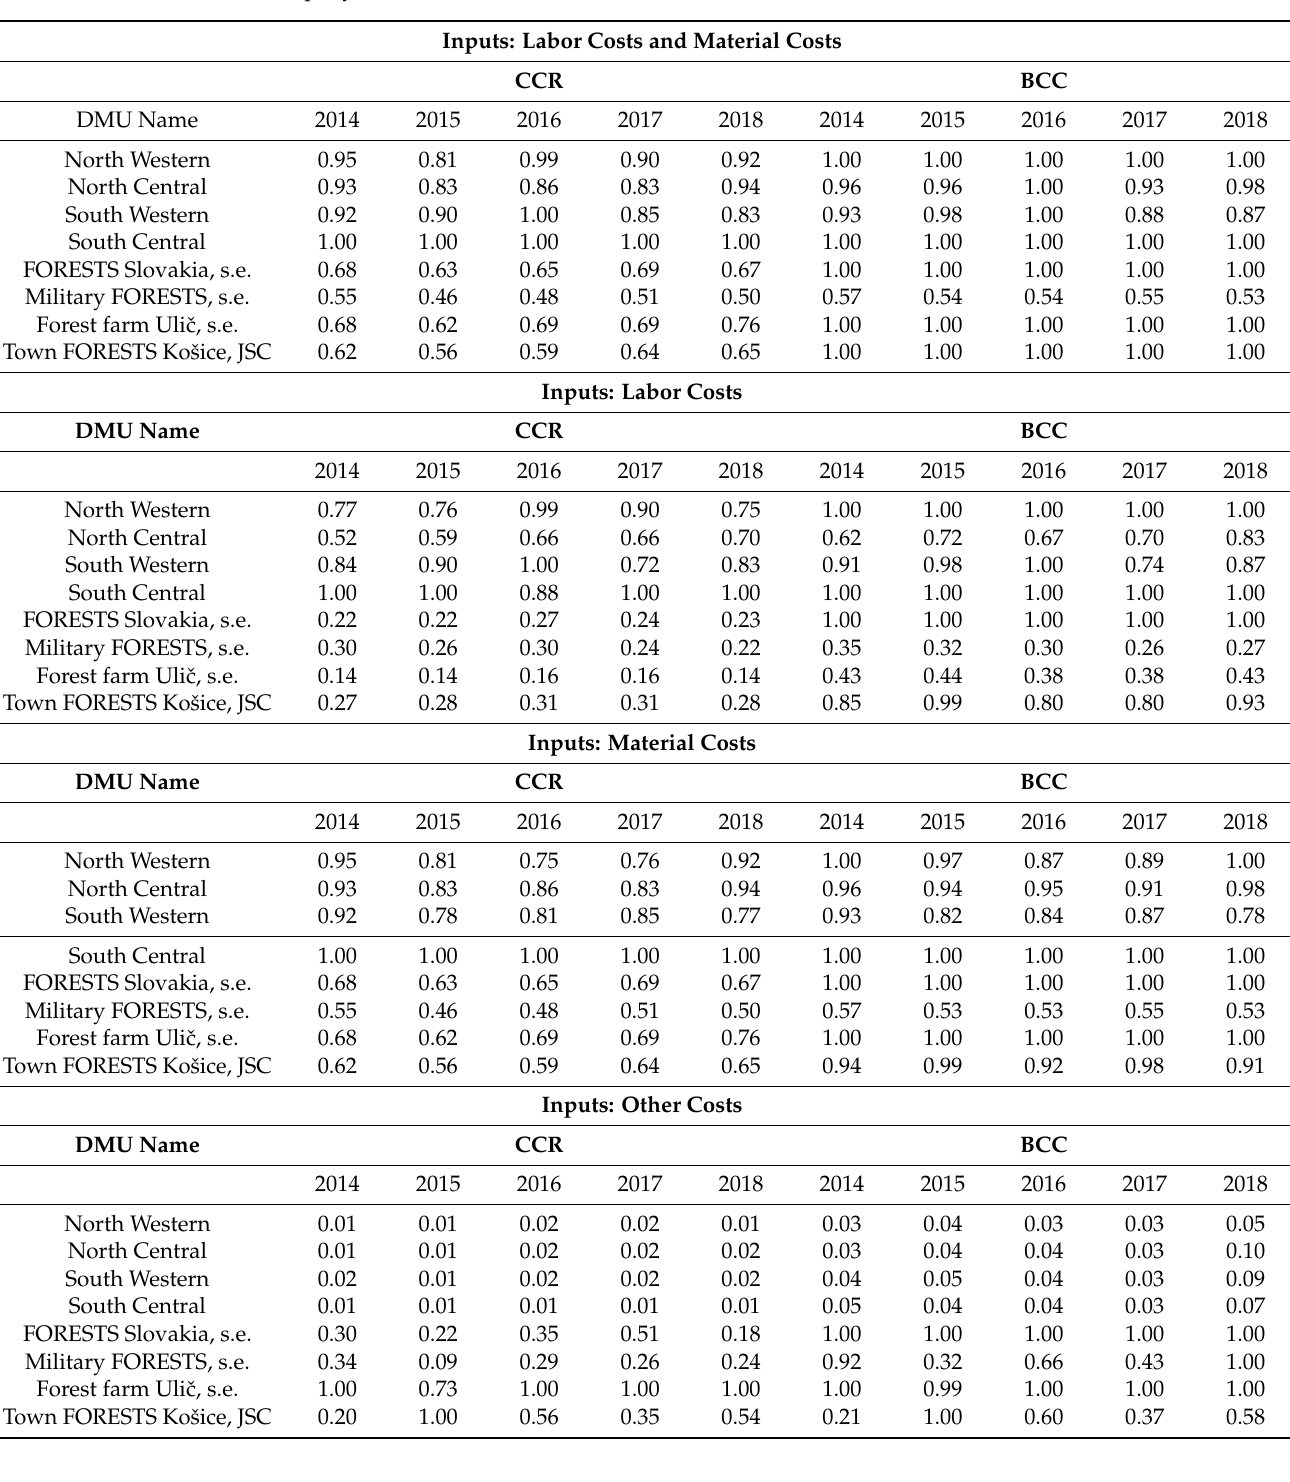
Table 1. Efficiency scores of the forest enterprises analyzed by the input-oriented models. (s.e. means State enterprise, JSC stands for Joint Stock